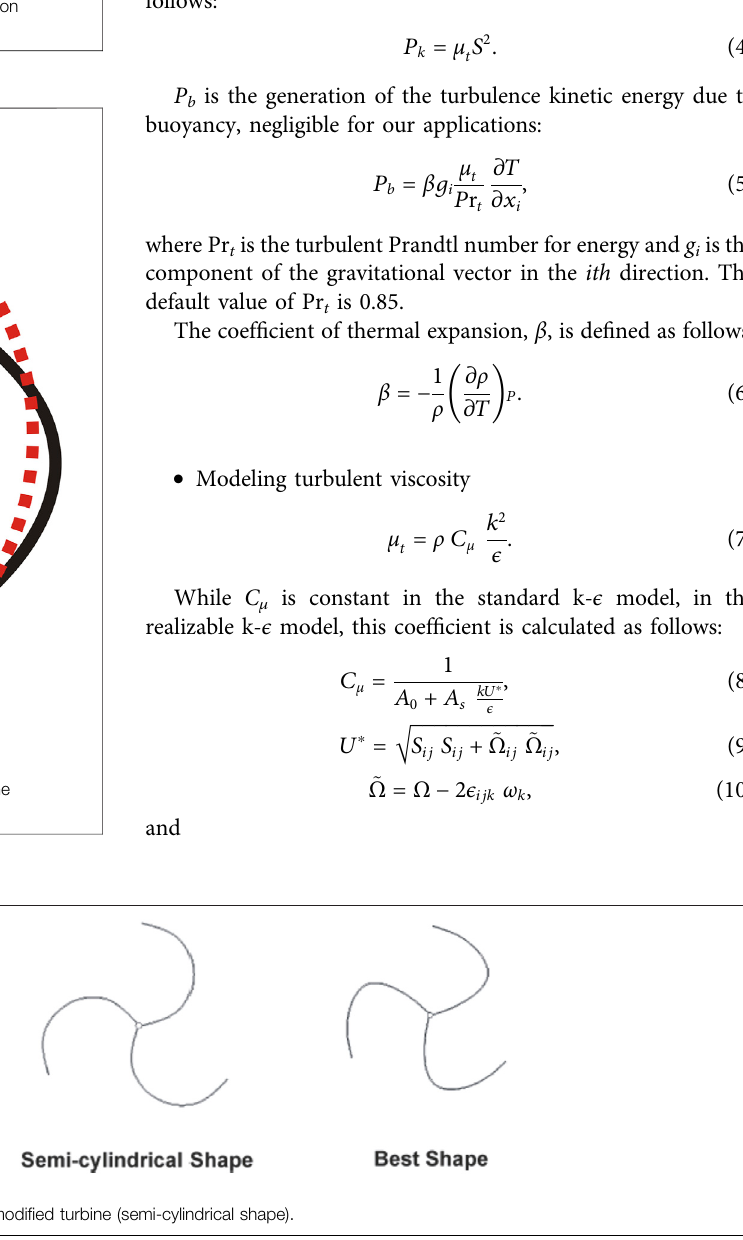
FIGURE 7 | Optimal and worst con fi gurations compared to the modi fi ed turbine (semi-cylindrical shape).